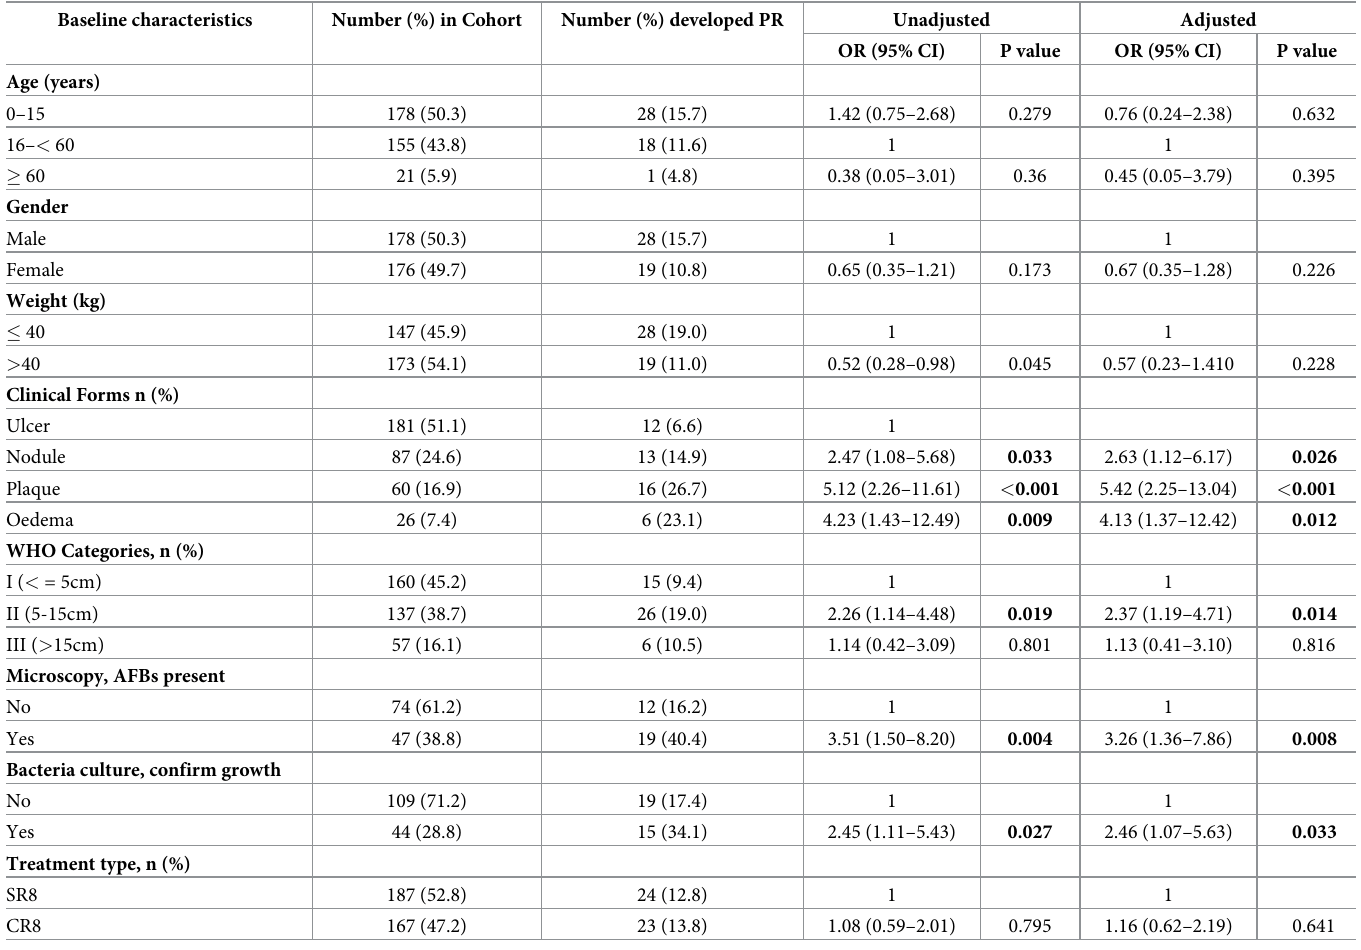
Table 2. Association between baseline characteristics and occurrence of paradoxical